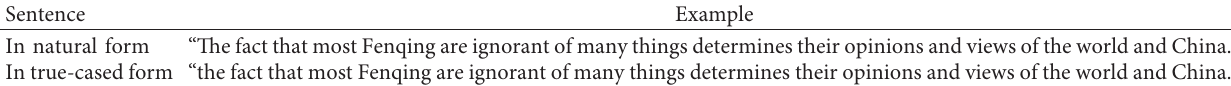
Table 5: An example of a sentence in its natural form and its converted true-cased form. Sentence Example In natural form